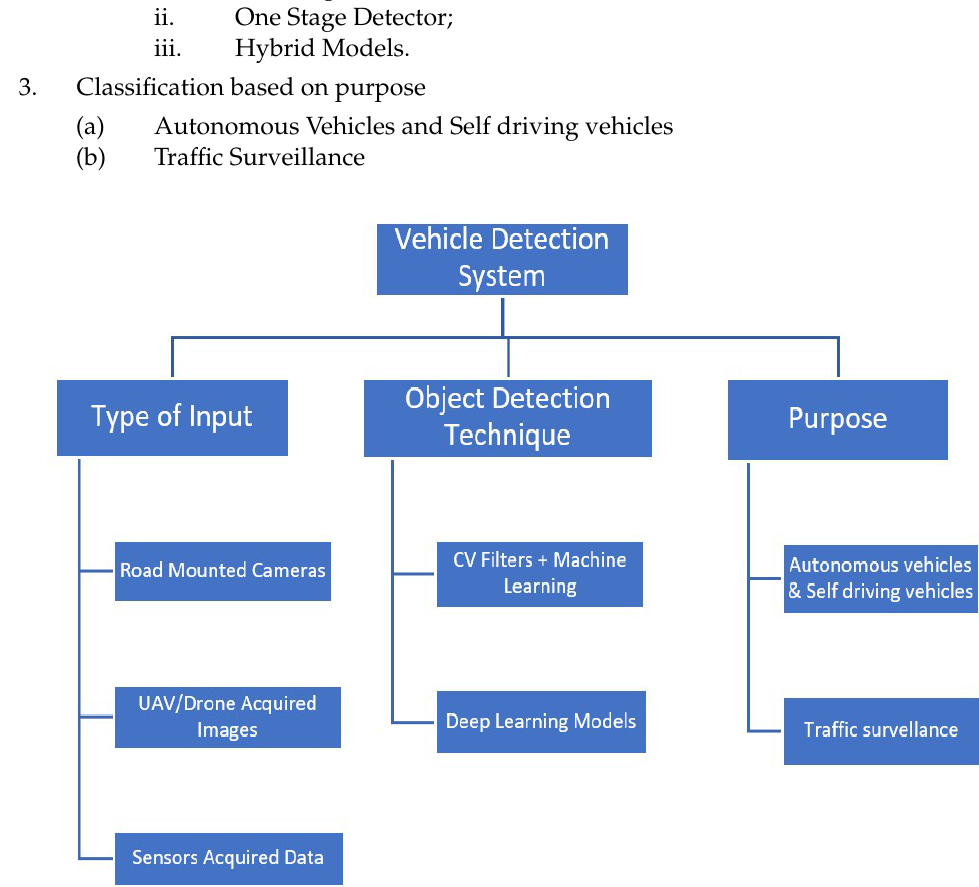
Figure 3. Classification of vehicle detection